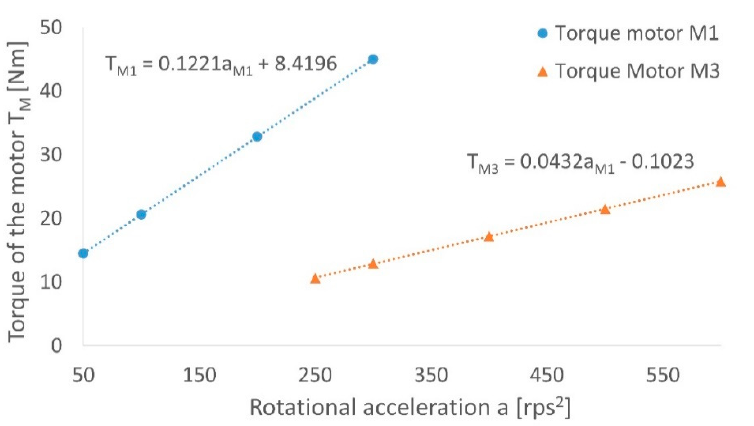
Figure 13. The influence of the rotational acceleration ε on the peak head/WDU drive motor torque for maximum rotational speed ω = 500 rev/s (for head drive) or ω = 3000 rev/s (for WDU drive).